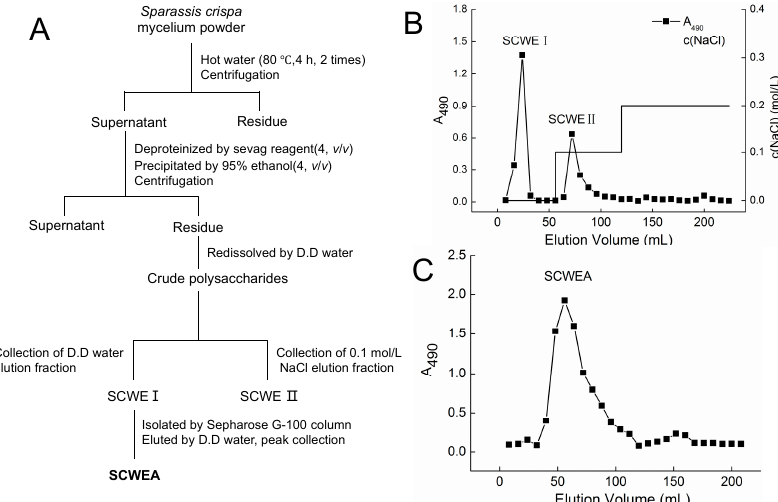
Figure 1. The purification of polysaccharides isolated from Sparassis crispa . ( A ) Scheme for extraction and isolation of polysaccharides from Sparassis crispa ; ( B ) DEAE-52 cellulose anion exchanged the chromatogram of the crude polysaccharides. SCWE I and SCWE II were eluted by double-distilled (D.D.) water and 0.1 mol/L NaCl at a flow rate of 1.0 mL/min, respectively; ( C ) The crude polysaccharide SCWE I was further purified via Sepharose G-100, and SCWEA was obtained. Table 1. Molecular weight and particle size.